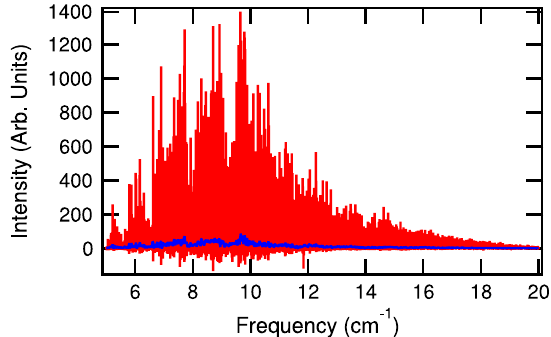
FIG. 3. Frequency spectrum for the normal bunch train show- bunch spectrum as described by Eq. (4) (red). Also shown is the low-resolution spectrum that precludes the observation of the effects of bunch-to-bunch coherence (blue) (see